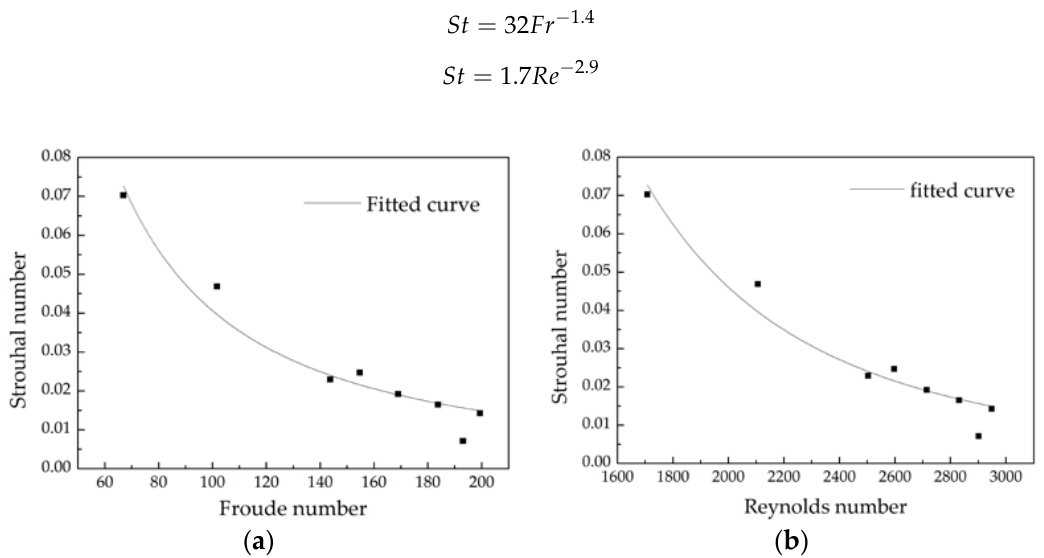
Figure 13. The variation in Strouhal number with ( a ) Froude number; ( b ) Reynold number.